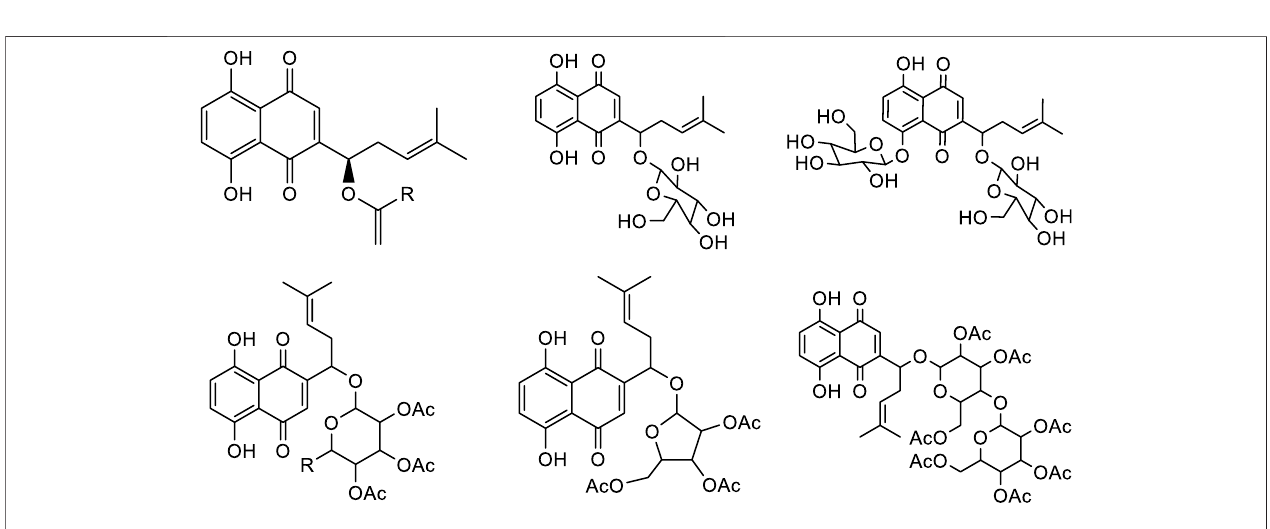
FIGURE 4 | Synthesis of shikonin oxime derivatives.